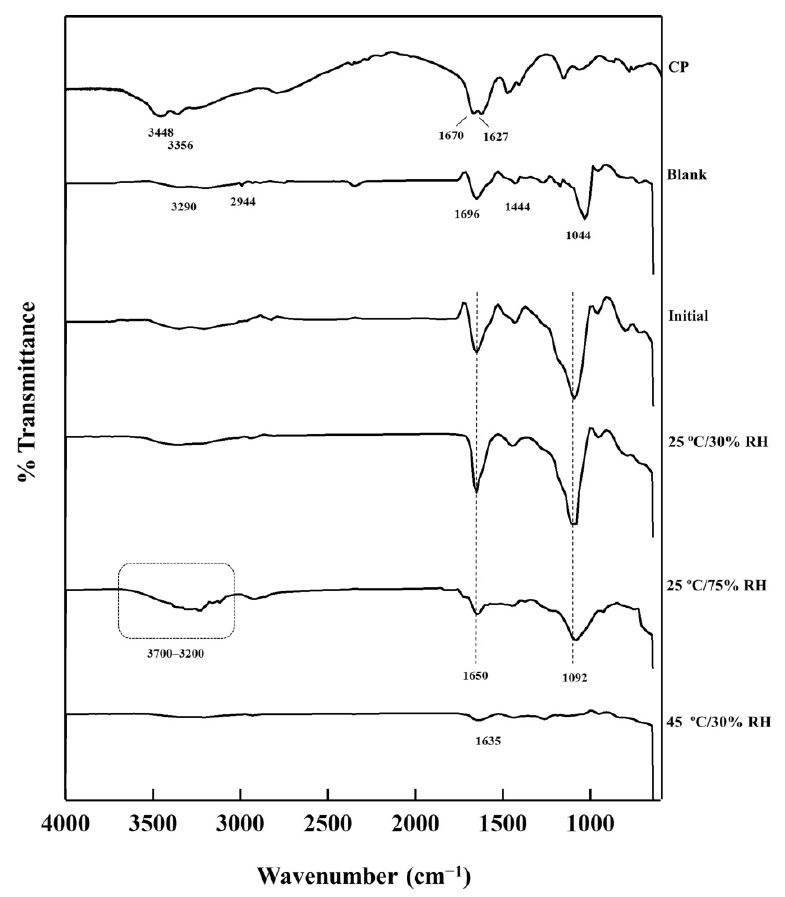
Figure 7. Fourier transform infrared spectroscopy (FTIR) spectrums of CP-F in the different storage conditions in comparison to the initial CP-F, CP, and blank nanofibrous film (blank).